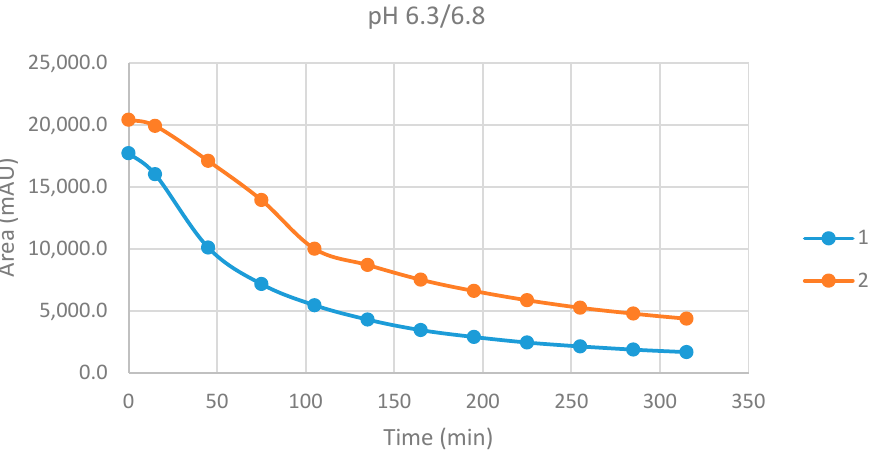
Figure 7. Change in the chromatographic peak area of chalcones 1 and 2 in the chalcone–GSH incubations at pH 6.3/6.8.